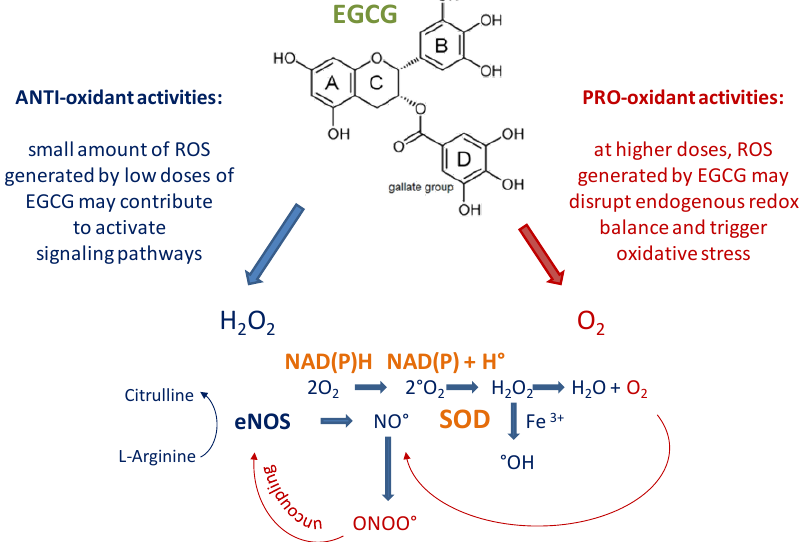
Figure 1. Simplified view of anti- and pro-oxidant activities of epigallocatechin-3-gallate (EGCG). Due to its relative chemical instability, EGCG may undergo autooxidation to produce O 2 and H 2 O 2 and accelerate the generation of hydroxyl radical (OH − ) from Fenton reaction. At lower biologic concentrations (1 µ M up to 10 µ M) the smaller amounts of intracellular reactive oxygen species (ROS) produced by EGCG are believed to stimulate multiple pathways and promote cellular protective mechanisms. At higher concentrations ( > 50 µ M) the pro-oxidant nature of EGCG predominates and may trigger cytotoxicity by disrupting redox balance mechanisms.